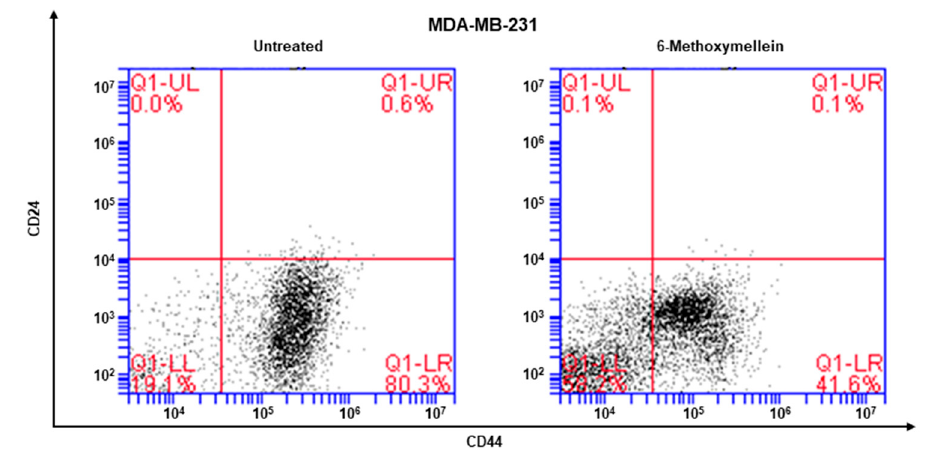
Figure 4. 6-Methoxymellein reduces the proportion of CD44 + /CD24 − cells. MDA-MB-231 cells were treated with 6-methoxymellein (1 mM) for 24 h. The CD44 + /CD24 − cell proportion was assessed by an Accuri C6 flow cytometer. The red cross was used for binding of a control antibody.